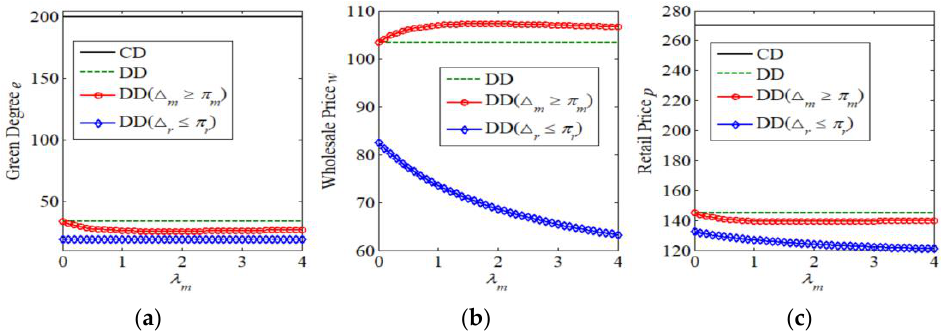
Figure 3. The effects of Signify’s levels of loss aversion on decision variables.